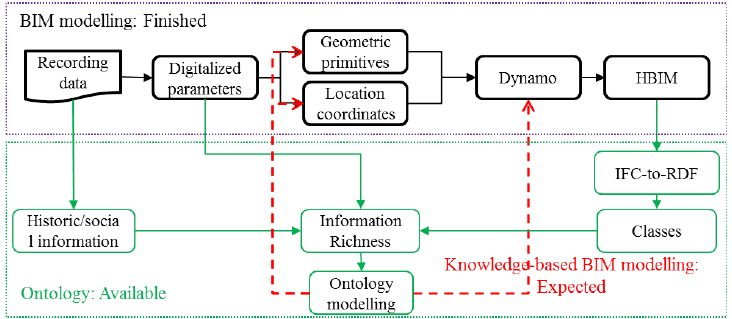
Fig. 7. The connection between BIM geometric aspect model and ontology semantics aspect